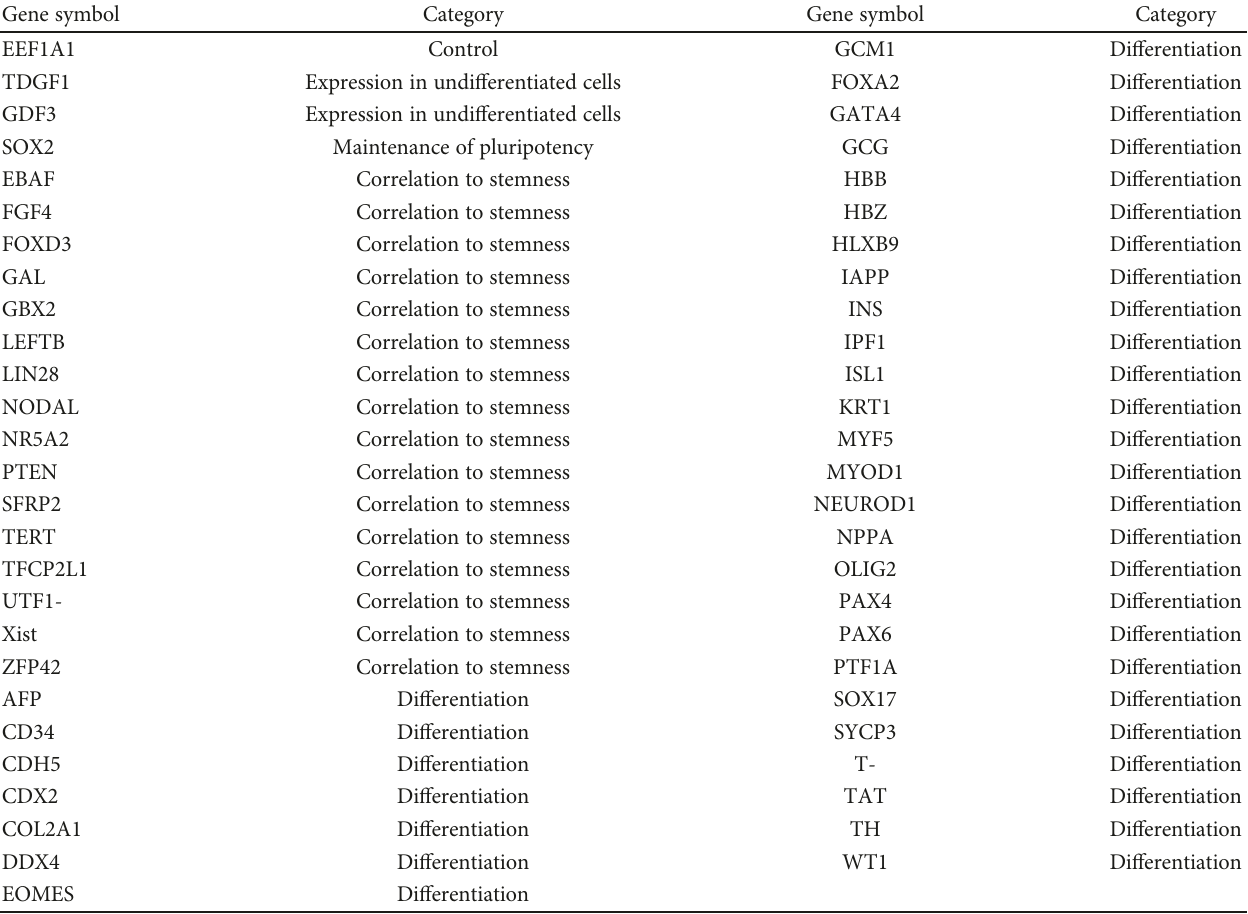
Table 1: List of genetic markers not expressed in